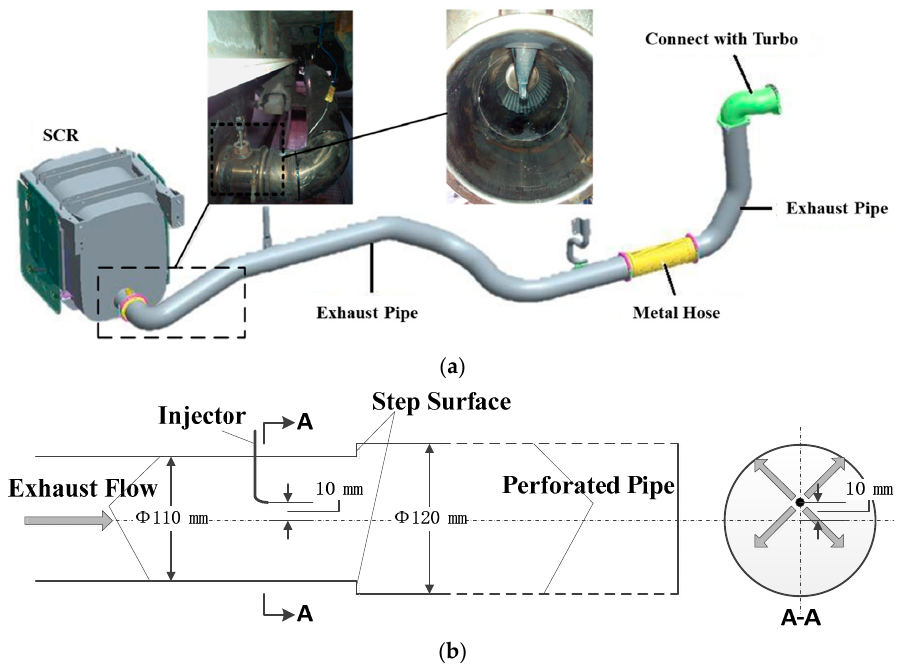
Figure 2. Diesel engine exhaust after-treatment system layout. ( a ) Arrangement and assembly of SCR system, ( b ) Sketch map of nozzle position and step surface.